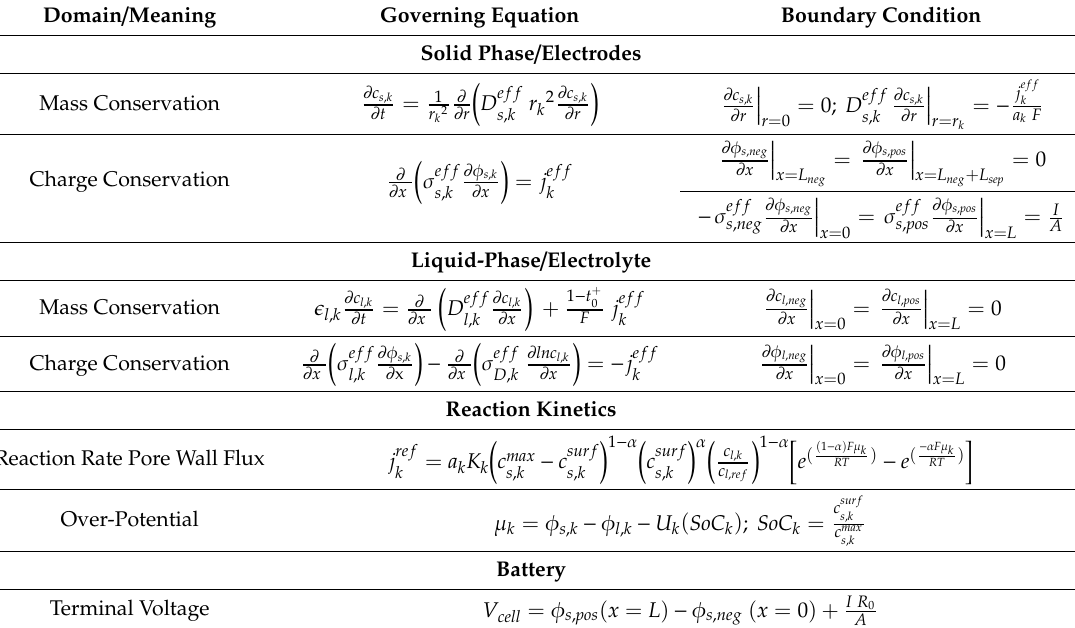
Table 1. The governing equations of the physico-chemical